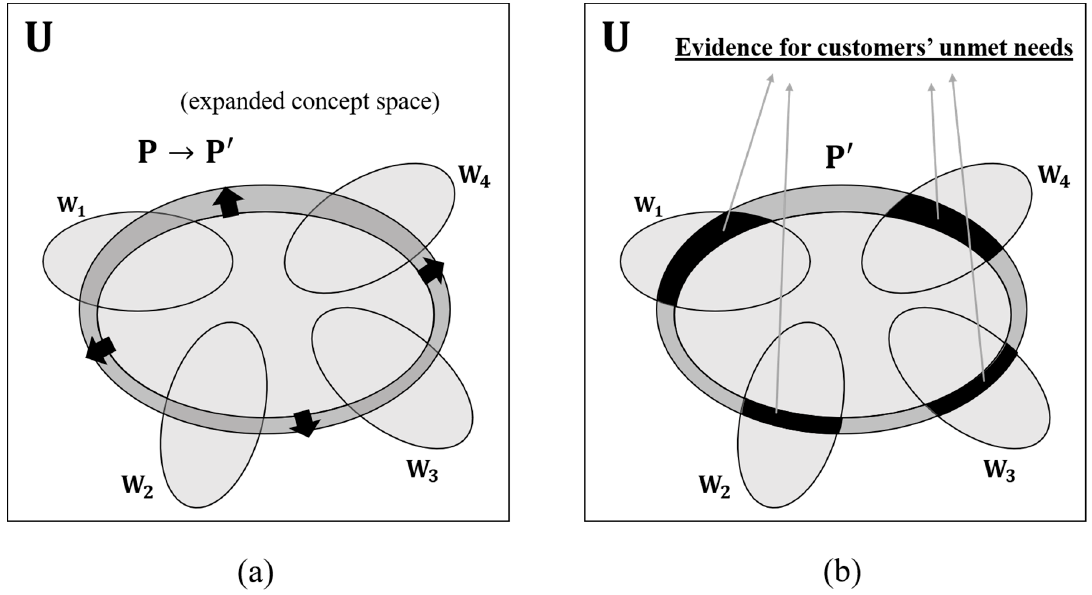
Figure 5. Expanding the concept space of the target product. ( a ) The concept space P is expanded to P ′ . ( b ) Shaded spaces can be regarded as evidence for the customer’s unmet needs and the new function of the target product.